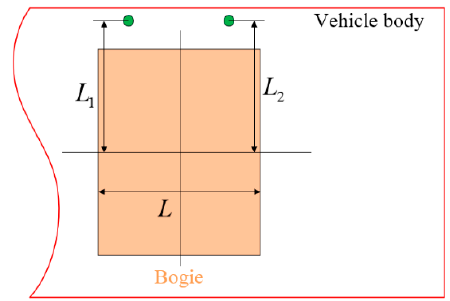
Figure 23. Simplified dimensioning of displacement measurement.